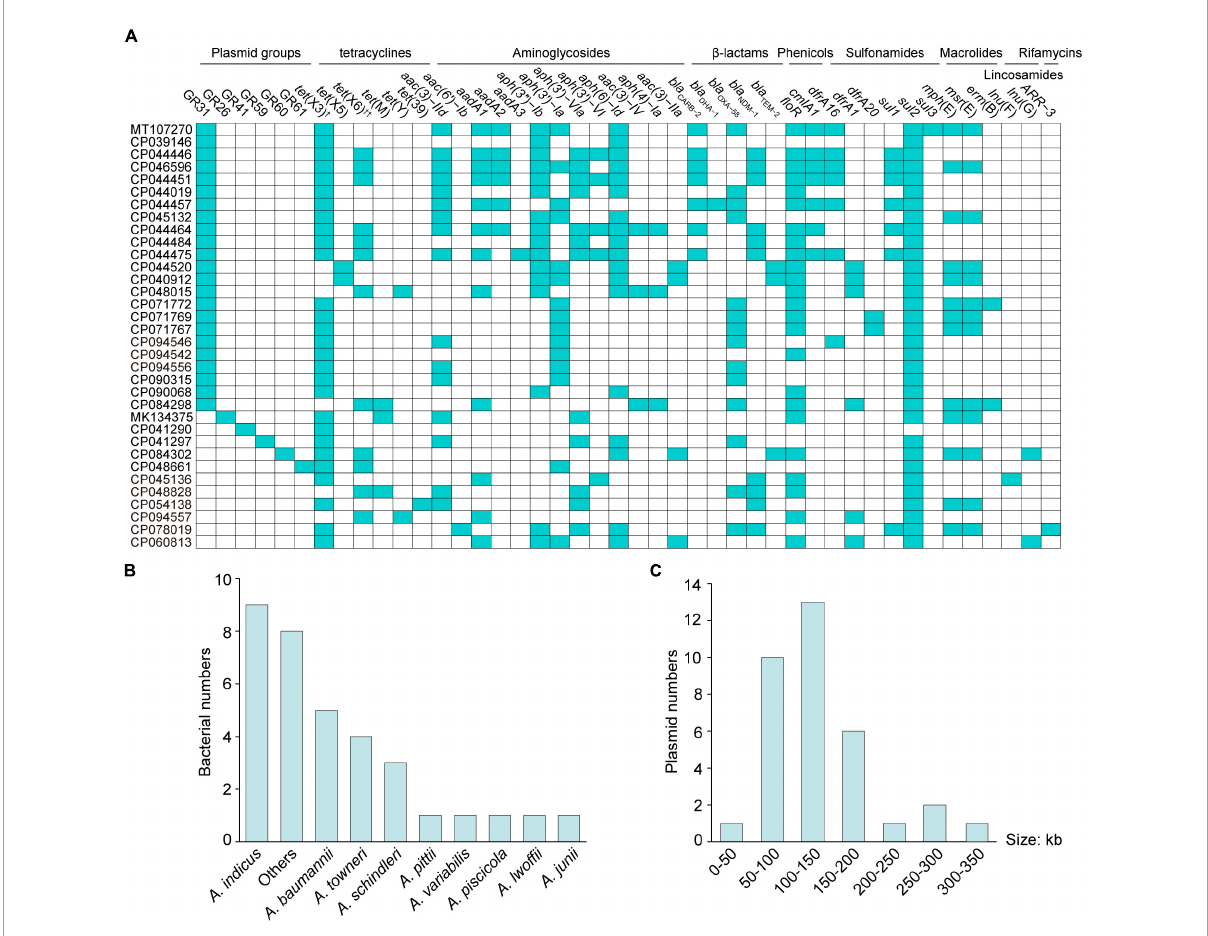
FIGURE1 Collection of the complete tet (X)-positive plasmids from Acinetobacter spp. strains. The distribution of plasmid groups (cyan, A ), plasmid-mediated ARGs (cyan, A ), bacterial species (B) and plasmid sizes (C) is presented. † One tet (X3) variant with a 99.7% amino acid identity (CP045132) with tet (X3) is included. †† Two tet (X6) variants (CP048828 and CP048661) with a 97.4% amino acid identity with tet (X6) are